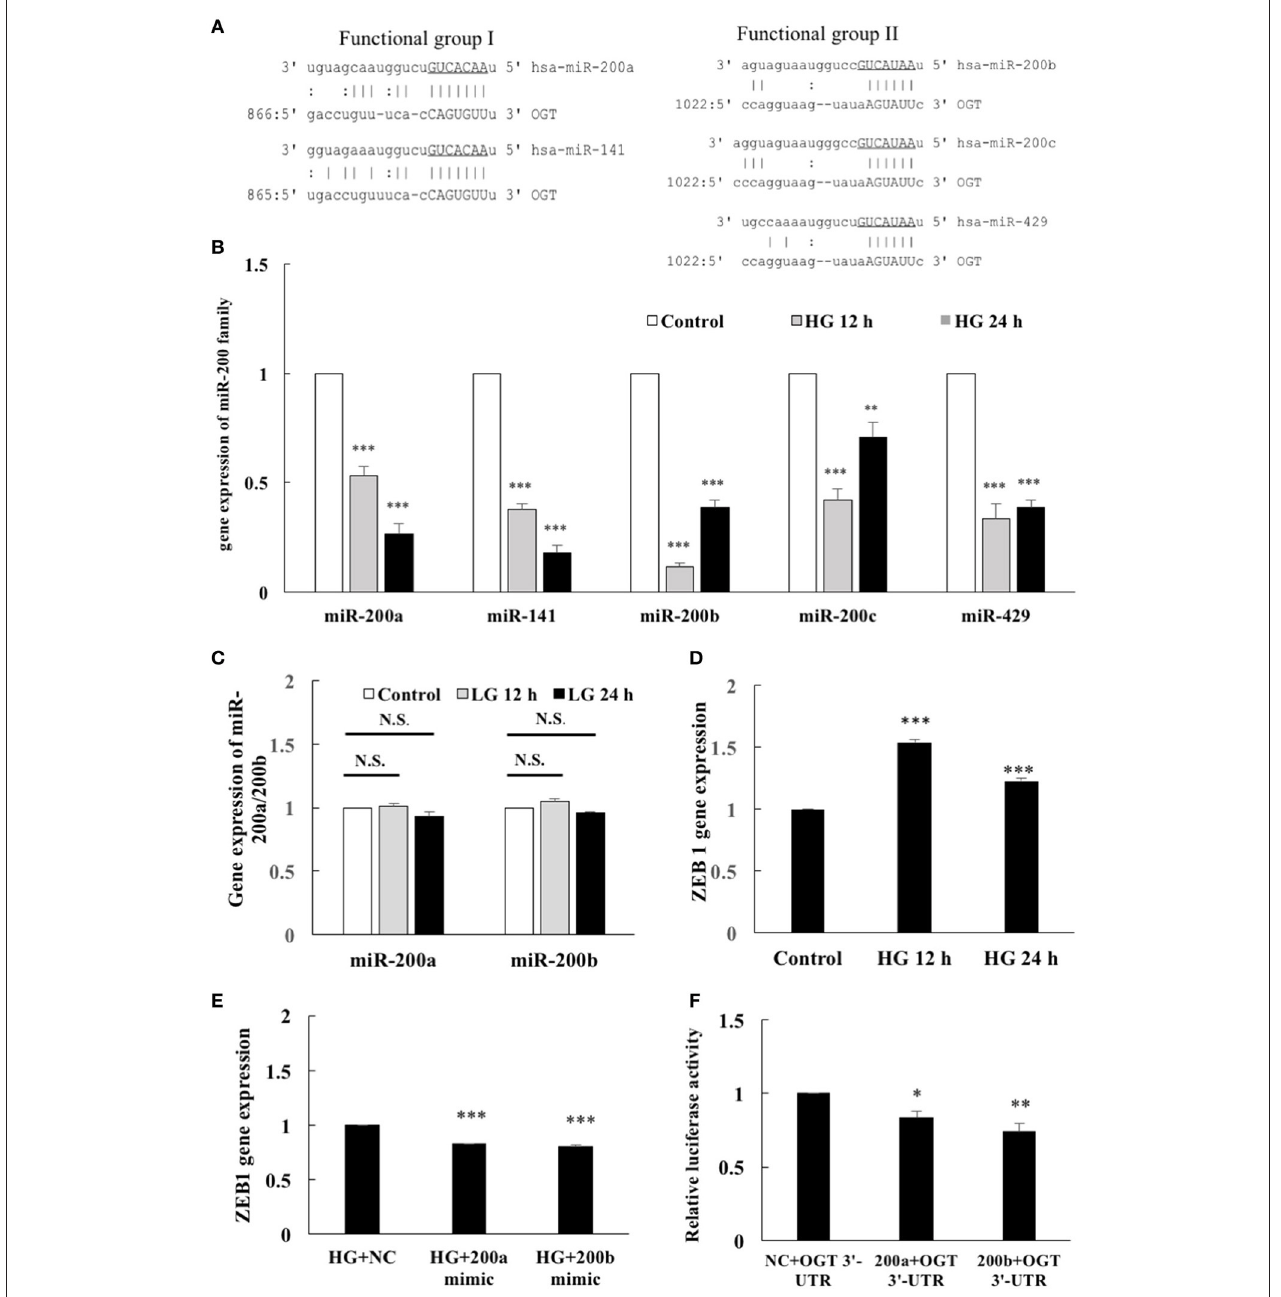
FIGURE 2 | OGT is a direct target of miR-200a and miR-200b. (A) Bioinformatics miR target analysis identified homologies between miR-200a, miR-141, miR-200b, miR-200c, miR-429, and the 3 ′ -UTR of human OGT mRNA, indicating potential regulation of OGT by these miRs. | AU or CG.: GU wobble. (B) Real-time PCR showed that HG stimulation for 12h decreased miR-200a, miR-141, miR-200b, miR-200c, and miR-429 expression levels to 53, 38, 11, 42, and 33% of the control level, respectively. Similarly, 24h HG stimulation decreased miR-200a, miR-141, miR-200b, miR-200c, and miR-429 expression levels to 27, 18, 39, 71, and 39% of the control level, respectively N = 5. ** p < 0.01 and *** p < 0.001 compared with control. miR expression levels were normalized to U6 expression. (C) LG did not modulate miR-200a/200b expression levels N = 4. N.S. not significant. (D) HAECs were stimulated with HG (25mM) for 12 and 24h. Real-time PCR demonstrates that stimulation of HAECs with HG induced 1.53-fold (12h) and 1.23-fold (24h) increases in ZEB1 mRNA levels N = 5. *** p < 0.001 compared with control. (E) miR-200a/200b mimic transfection inhibited HG-induced endothelial ZEB1 mRNA expression to 83 and 80% of the control level, respectively, in the HG-stimulated HAECs N = 4. *** p < 0.001 compared with the HG-treated HAECs transfected with a negative control (HG + NC). (F) A luciferase reporter assay showed that cotransfection of pmirGLO-OGT-3 ′ -UTR and the miR-200a/200b mimics downregulated the luciferase signal to 83 and 74%, respectively, of the control luciferase signal, respectively N = 5. * p < 0.05 and ** p < 0.01 compared with the negative control.